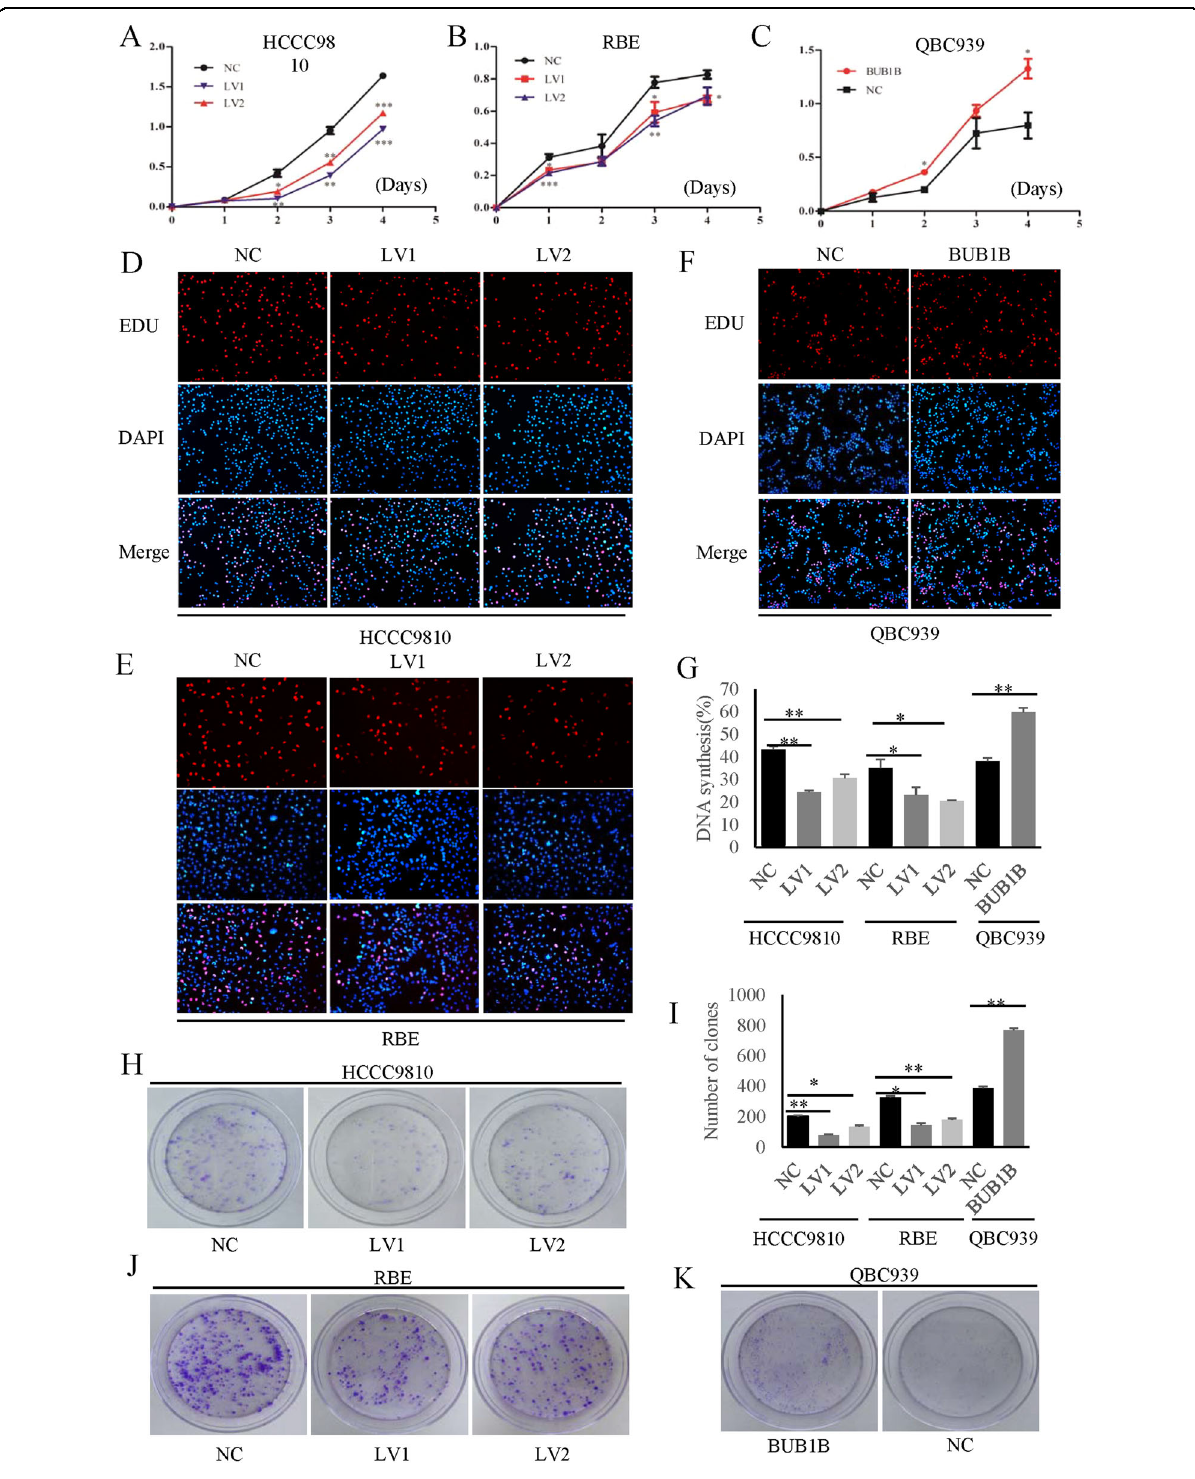
Fig. 2 BUB1B promoted CCA cell proliferation. A – C Cell growth suppression was observed in knockdown group compared with control group in both HCCC9810 and RBE cells. In turn, the upregulated expression of BUB1B contributed to the proliferation of CCA cells. D – G The EdU staining demonstrated that the knockdown of BUB1B inhibited the proliferation of CCA cells while the over-expression of BUB1B promoted the cell proliferation. H – K The colony number and size were signi fi cantly lower in BUB1B knockdown group compared to control group. In contrast, the over- expression of BUB1B promoted the colony formation (* p < 0.05; ** p <